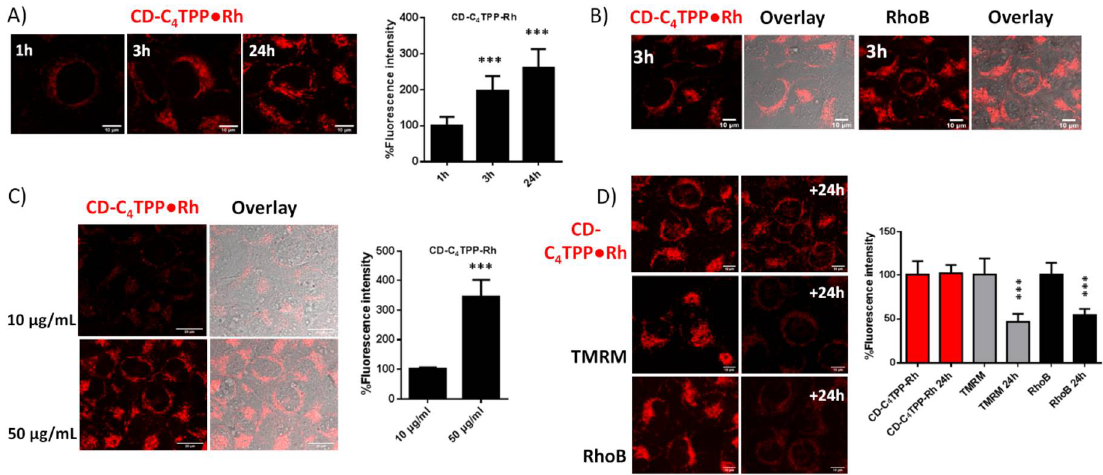
Figure 5. Internalization and retention patterns of CD-C4TPP • Rh in live MDA-MB-231 cells. Cells were treated with: ( A CD-C4TPP • Rh 50 µ g/mL for 1, 3 and 24 h, ( B ) 50 µ g/mL CD-C4TPP • Rh (RhoB 350 nM) and with plain RhoB (350